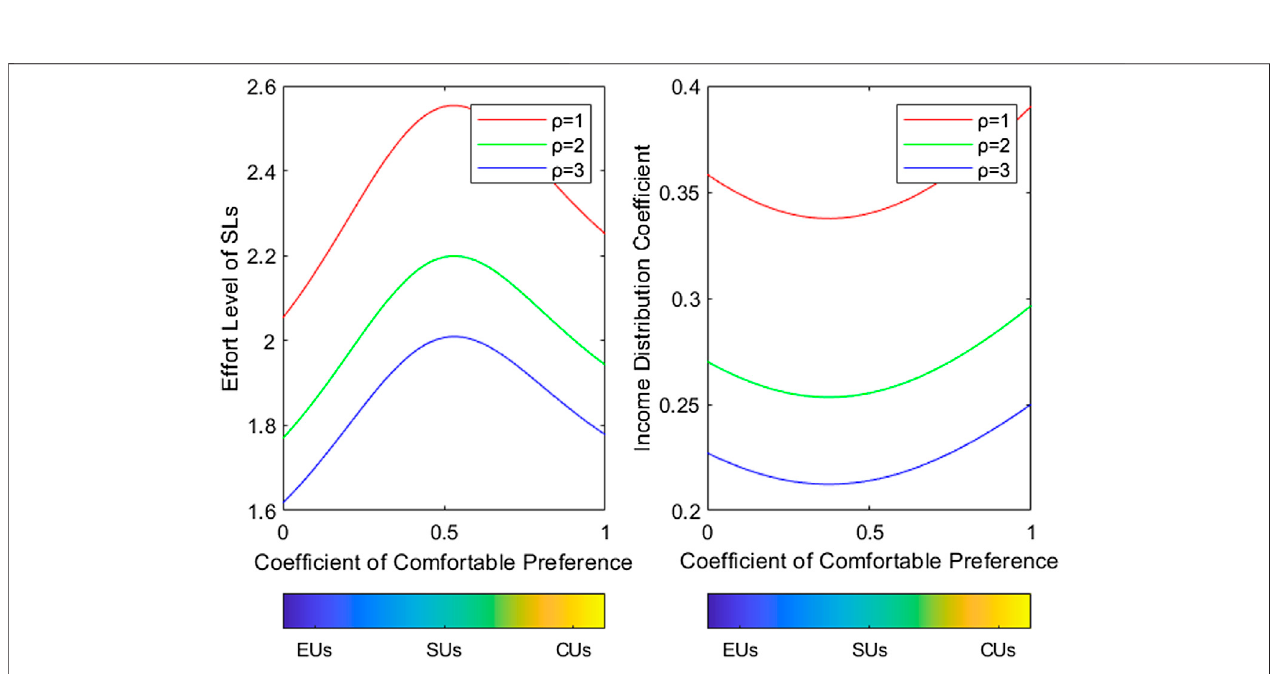
when the LA dispatches the jth SLs, respectively. In this article, SLs with the same preference have the same lower limit and upper limit regulation interval of physical temperature. Under different scheduling strategies, the main calculation steps of the adjustable power of SL electric heating are shown in Figure 8 :